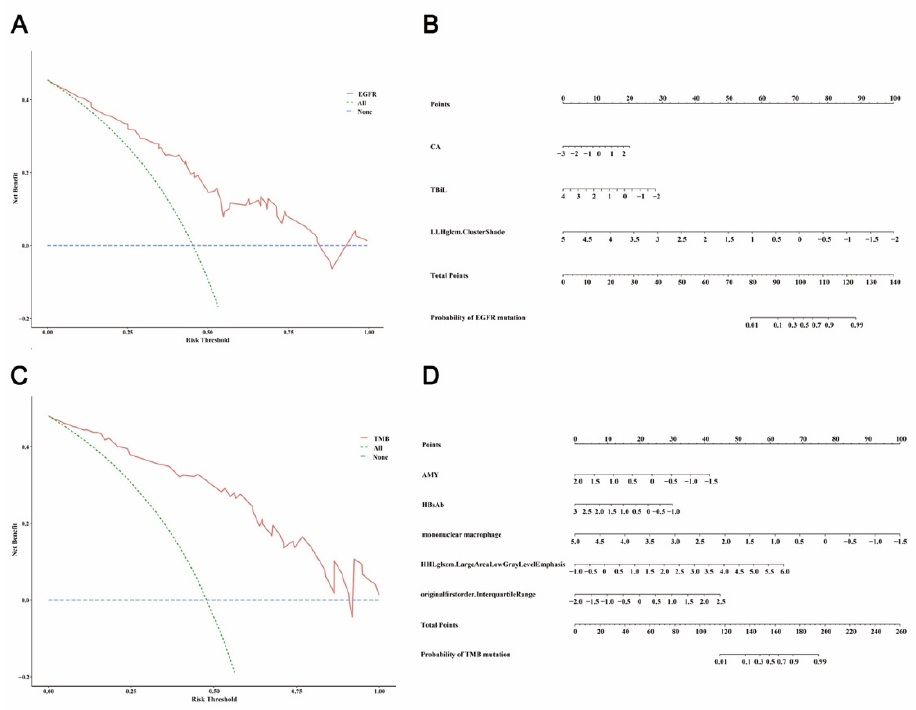
Figure 4. The nomogram and decision curve of the integrated prediction model for EGFR mutations tions ( A , B ) and TMB status ( C , D ( A , B ) and TMB status ( C , D ).